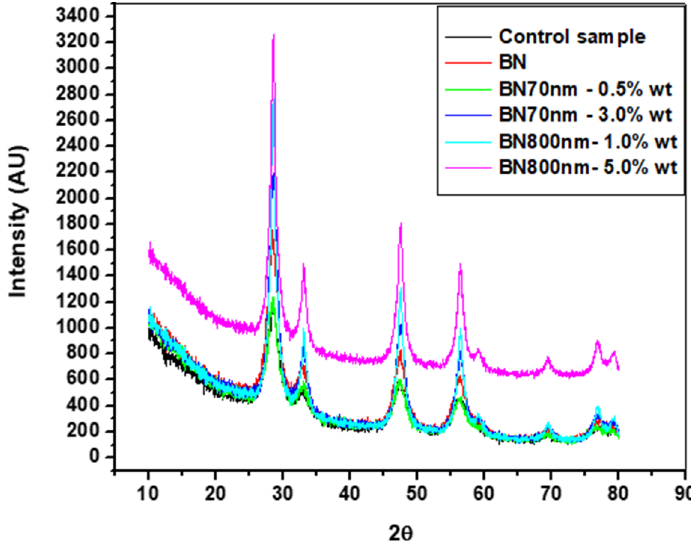
Figure 5. XRD patterns of the specimens made by ultrasonic mixing with different h ‐ BN nanofillers in PMMA.